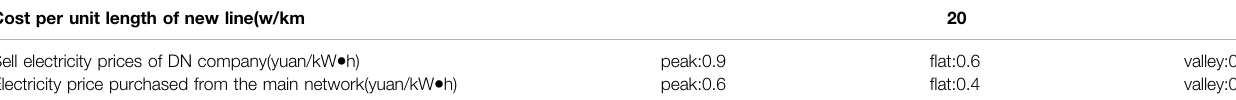
TABLE 3 | Distribution network relevant parameters.